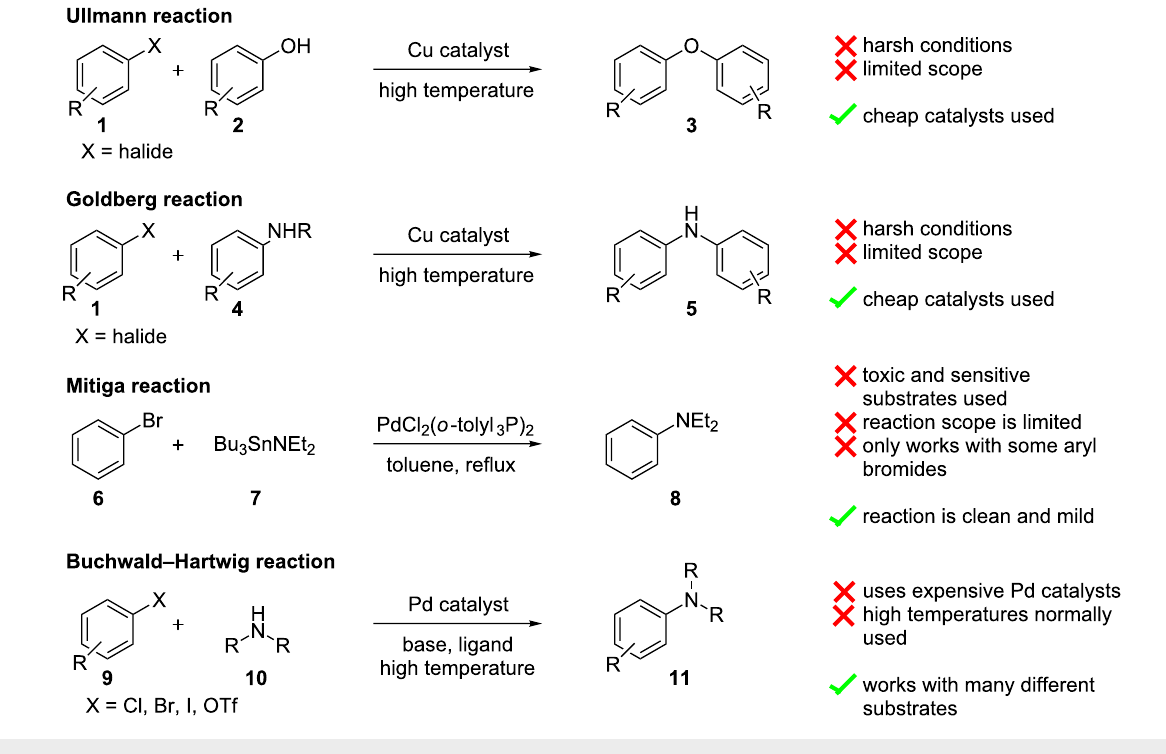
Scheme 1: Comparison of early C–N and C–O coupling